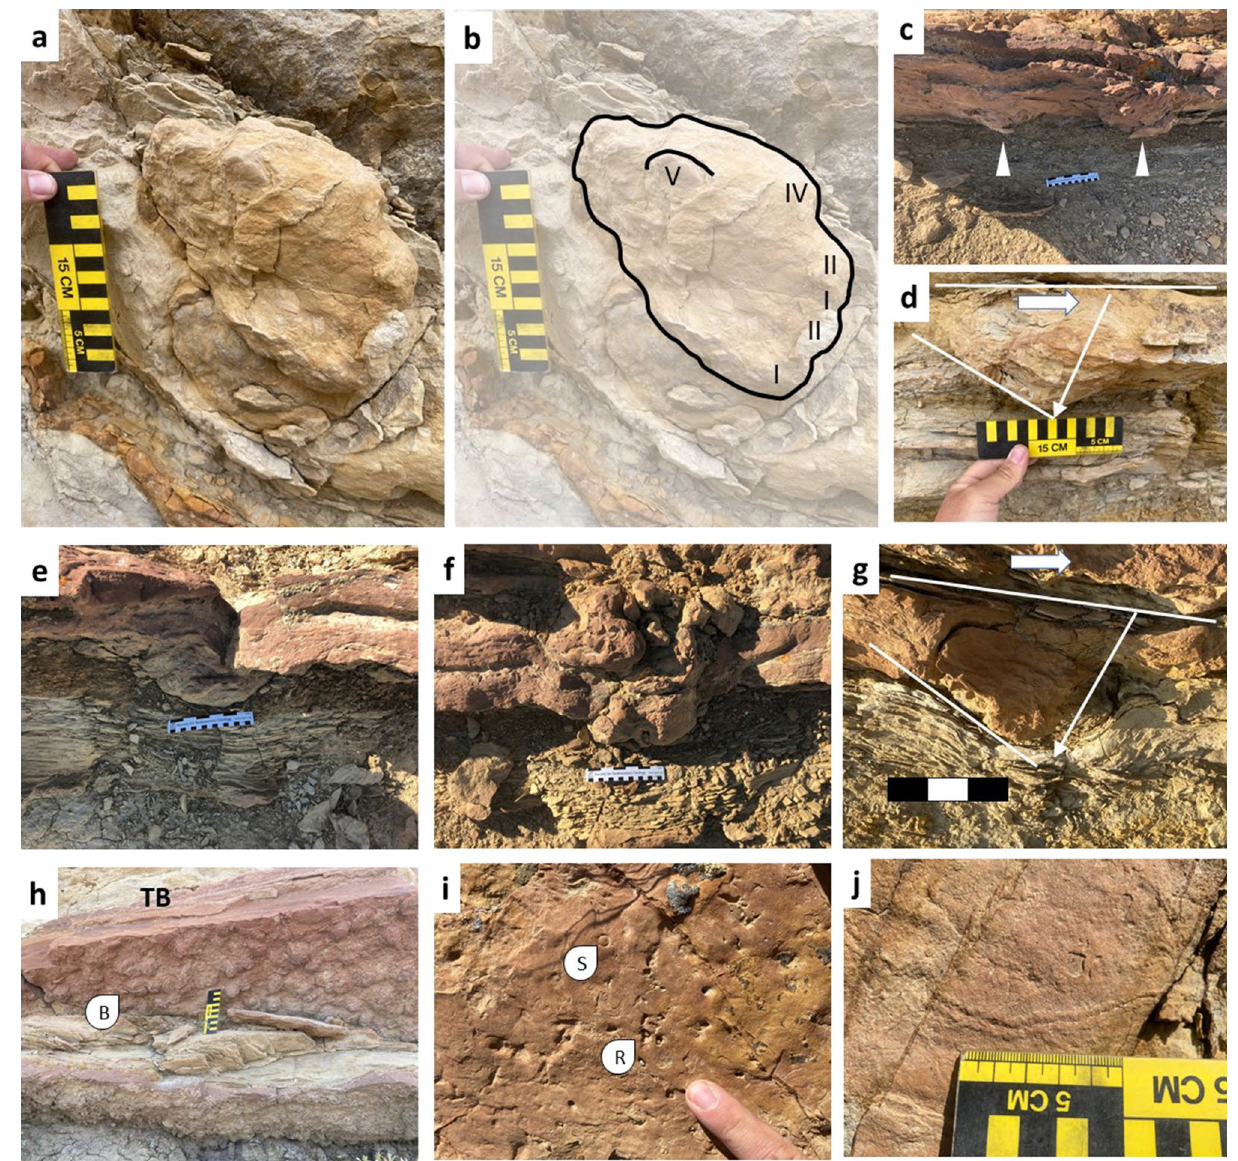
Figure 3. Photographs of representative examples of penetrative prints and associated brackish-water ichnofossils. Scale bars are 15 cm. ( a ) Natural cast of blunt-toed print left by animal walking left to right (southeast to northwest); ( b ) Interpretive outline of A; ( c ) Consecutive footsteps of an animal walking left to right (southeast to northwest),arrows indicate penetration of footprints; ( d ) Print made by animal walking right to left (southeast to northwest), small arrow indicates downward rotation of foot during step-off; ( e ) Underprint in silty claystone 20 cm below sandstone bed; ( f ) Penetrative print with underprint in silty claystone and deformation in track-bearing sand; ( g ) Natural sandstone cast and penetrative print exhibiting downward rotation of animal walking left to right (southeast to northwest); ( h ) Underside of a track-bearing silty sandstone bed (TB) with abundant Bergaueria (B) at the base, overlying a siltstone bed with additional Bergaueria at the base; ( i ) Upper surface of silty sandstone bed with abundant, small Rhizocorallium (R) and Siphonichnus (S) among other marine ichnofossils. Index finger of AF-JW for scale; ( j ) Gyrochorte in very fine-grained sandstone bed underlying track-bearing siltstone. Photographs by A F-J W and compiled in Microsoft PowerPoint